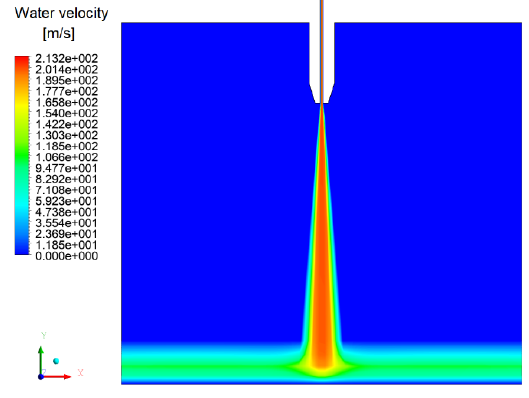
Figure 1. Contour of water in CFD simulation [11] The graphical shape of water velocity up to 4 mm standoff distance resulted within a pale of CFD simulation as presented in Figure 2.